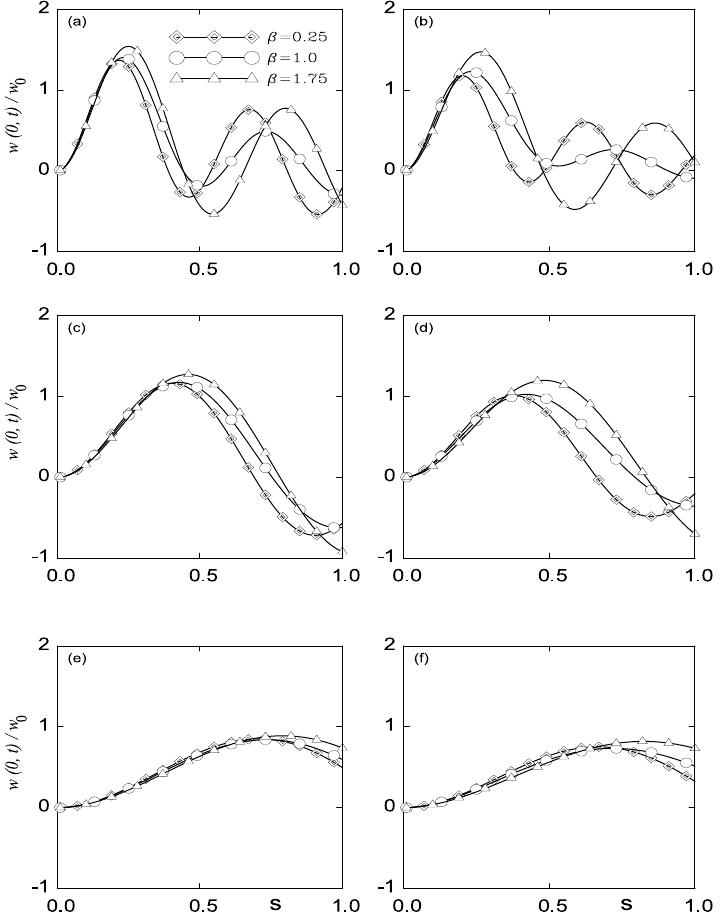
Fig. 5. Dynamic response ( w (0 ,t ) /w 0 ) for a free- fi xed beam: (a) α = 0.25, ζ n = 0.1, (b) α = 0.25, ζ n = 0.2, (c) α = 0.5, ζ n = 0.1, (d) α = 0.5, ζ n = 0.2, (e) α = 1, ζ n = 0.1, (f) α = 1, ζ n =